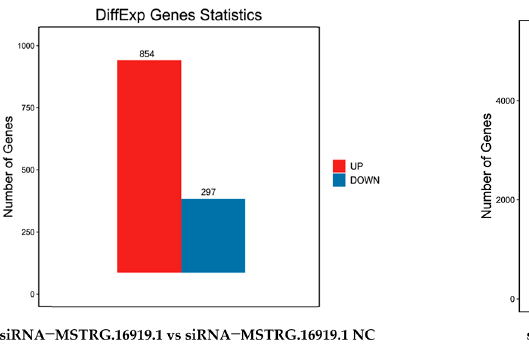
Figure 2. Statistical diagram of differential genes. ( a ) Gene statistics of the difference between siRNA − MSTRG.16919.1 and siRNA − MSTRG.16919.1 NC ; ( b ) siRNA − MSTRG.16919. 1 and BHV − 1 33 h differential genes statistics; ( c ) repeat gene screening for groups a and b.